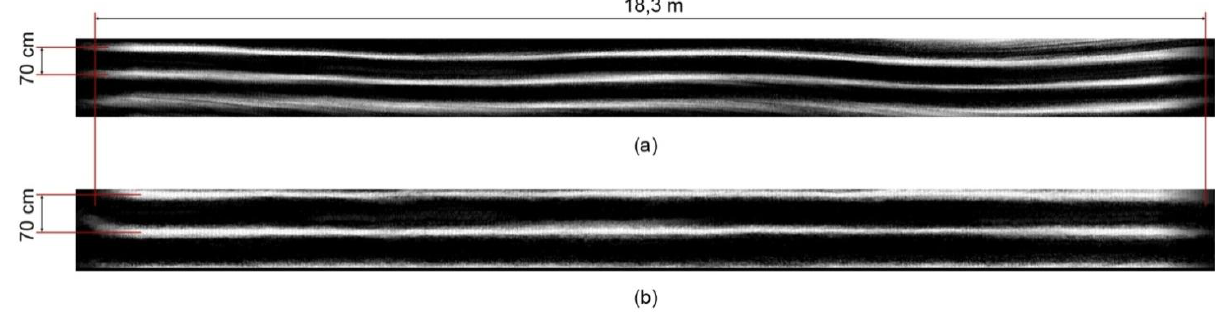
Figure 7. In this case, the sequence corresponds to a sunny day on a field with low weed cover. (a) The grayscale image of the generated map for the video sequence without stabilization depicts crop rows meandering slightly along the moving direction; (b) After the stabilization process, the crop rows stay completely straight despite the slight sway of the